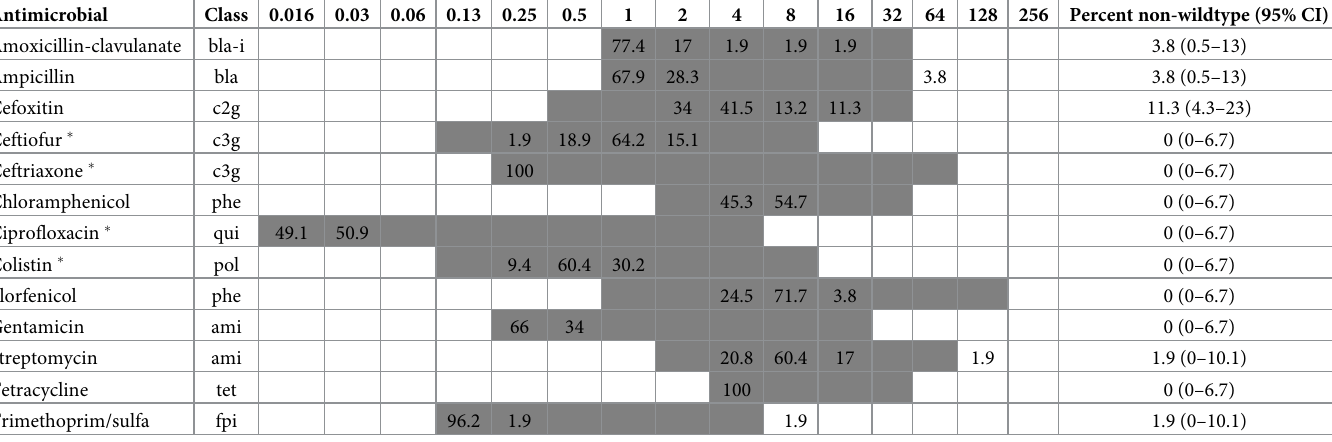
The shaded areas indicate the range of dilutions tested for each antimicrobial. ECOFF values are shown with vertical bars. ami = aminoglycosides, bla = beta lactams,